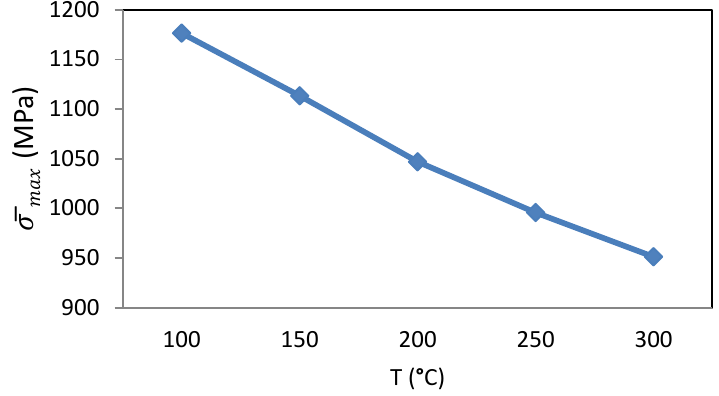
Figure 13. Influence of the temperature on the sleeve maximum effective stress.